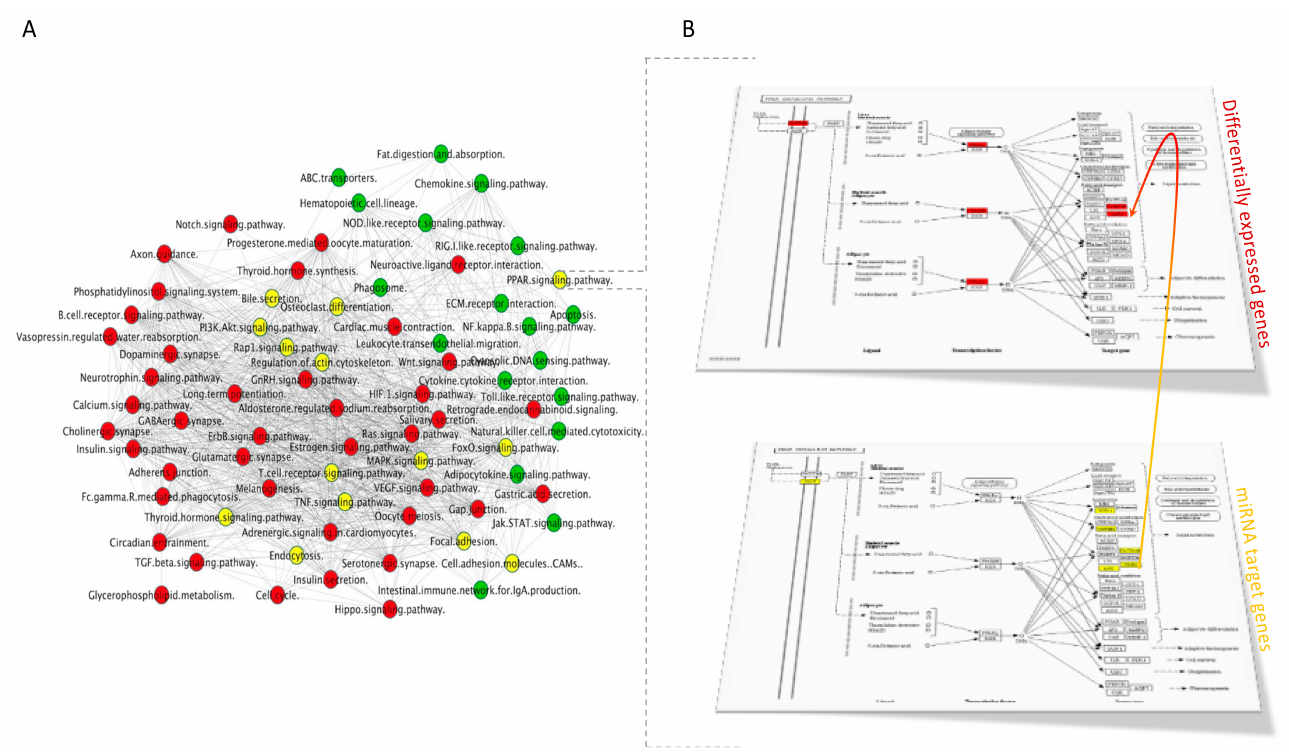
Figure 9. ( A ) mRNAs and miRNA-targets network of pathways. List of differentially expressed genes and miRNA targets were used to perform a global GeneTrail2 enrichment analysis and identify enriched pathways. A pathway-connections network was built in Cytoscape. Node colored labels represent the categories (mRNA, miRNA targets or combination) from which the pathways were enriched. Red circles are miRNA pathways, yellow are miRNA and mRNA pathways, green are mRNA pathways. ( B ) PPAR signaling pathway in 2 levels, one for mRNA and one for miRNA